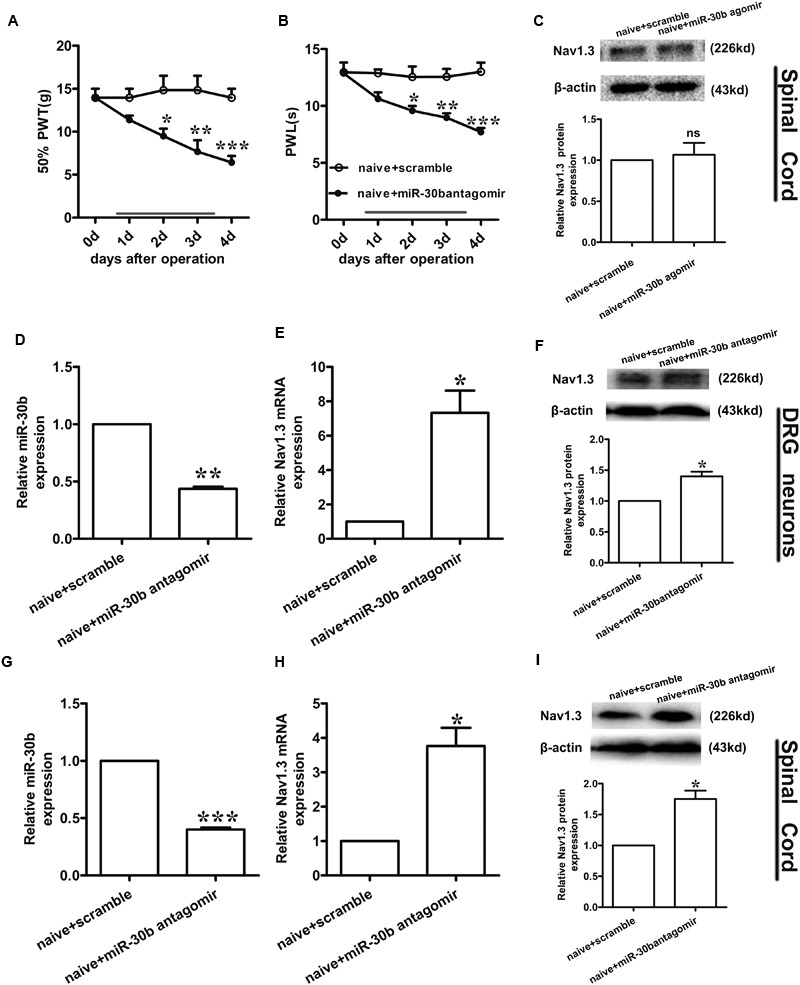
Nav1.3 was upregulated by miR-30b antagomir with pain behaviors. (A,B) Responses to mechanical and thermal stimulus, ∗P < 0.05, ∗∗P < 0.01, ∗∗∗P < 0.001 vs. naïve + scramble, two-way ANOVA, n = 6 rats. (C) Nav1.3 protein expression in spinal cord of rats injected with miR-30b agomir, P = 0.6914 vs. naïve + scramble, two-tailed paired t-test, n = 3 rats. (D,E) The relative mRNA expression of miR-30b (D) and SCN3A (E) with intrathecal miR-30b antagomir in DRG neurons of naïve rats, ∗P = 0.0394, ∗∗P = 0.0011 vs. naïve + scramble, one-way ANOVA, n = 3 rats. (F) Nav1.3 protein expression in DRG neurons of naïve rats at 4 days injected with intrathecal miR-30b antagomir, ∗P = 0.0341 vs. naïve + scramble, two-tailed paired t-test, n = 3 rats. (G,H) The relative mRNA expression of miR-30b (G) and SCN3A (H) with intrathecal miR-30b antagomir in spinal cord of naïve rats, ∗P = 0.0344, ∗∗∗P = 0.0009 vs. naïve + scramble, one-way ANOVA, n = 3 rats. (I) Nav1.3 protein expression in spinal cord of naïve rats at 4 days injected with intrathecal miR-30b antagomir, ∗P = 0.0309 vs. naïve + scramble, two-tailed paired t-test, n = 3 rats. Data are shown as means ± SEM.